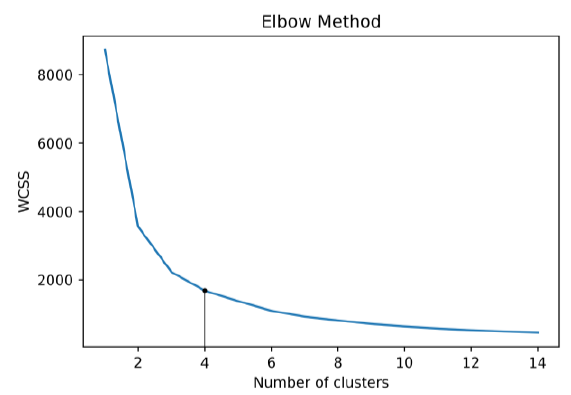
Figure 4 . Elbow method, clusters for the data = 4.